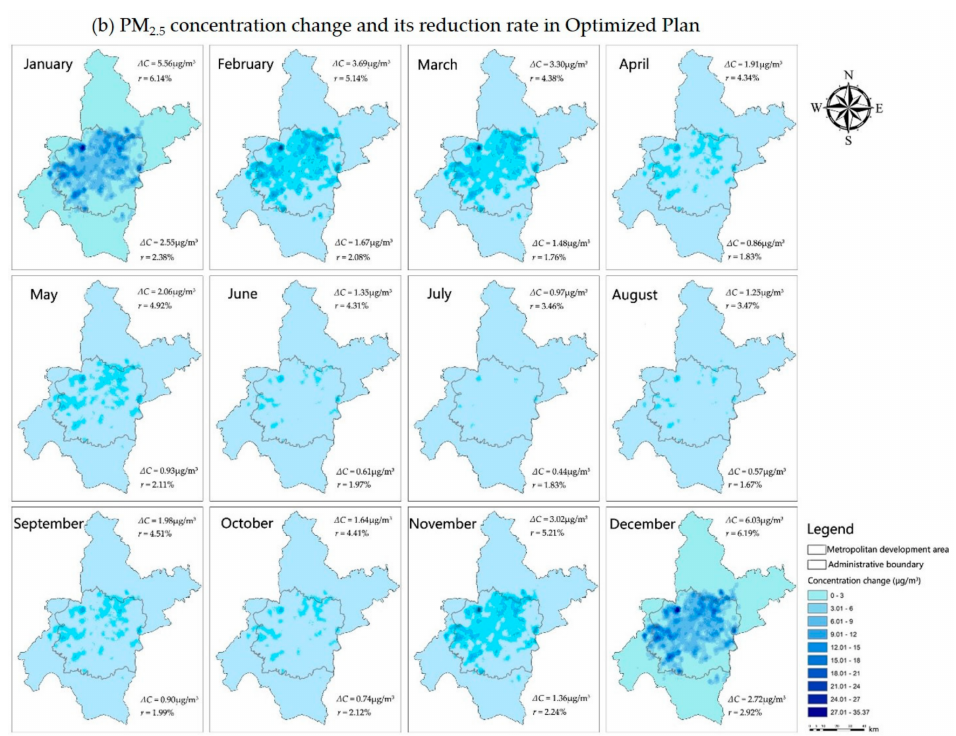
Figure 5. PM 2.5 concentration change and reduction rate for ( a ) the basic plan and ( b ) the optimized plan. The ∆ c and r in the upper right in every sub-figure illustrate the change in the metropolitan development area, while in the lower right represent the change in Wuhan’s administrative